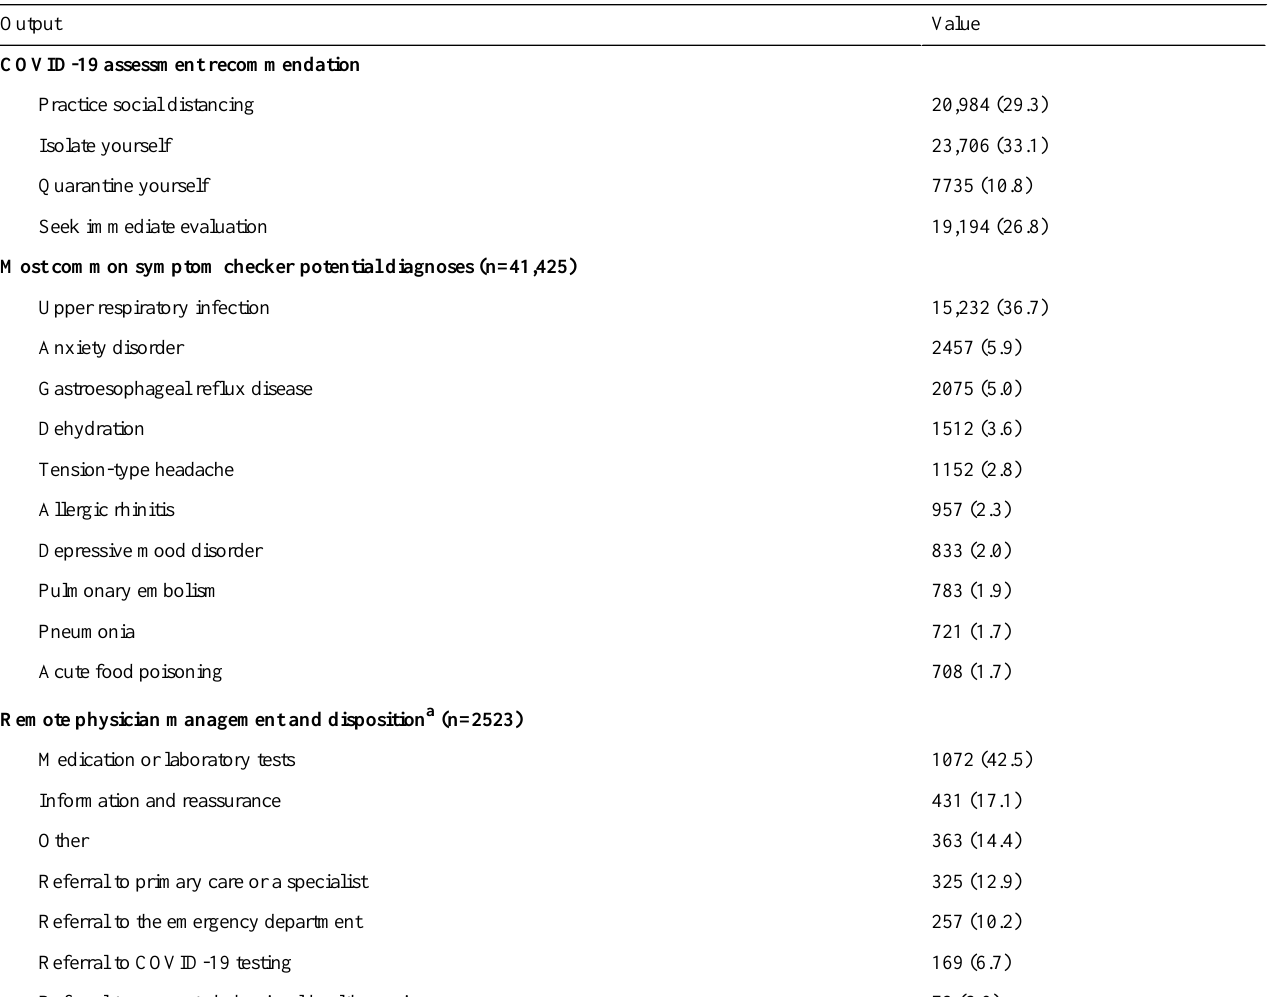
Table 2. Outputs provided by the digital health tools (N=71,619), n